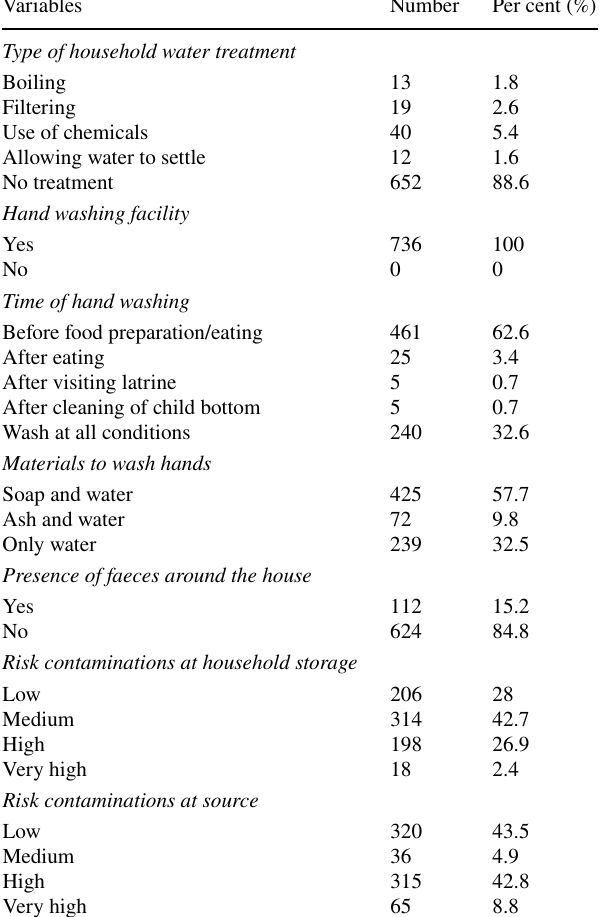
Table 3 Distribution of behavioural characteristics of respondents in North Gondar Zone, 2016 ( n = 736)